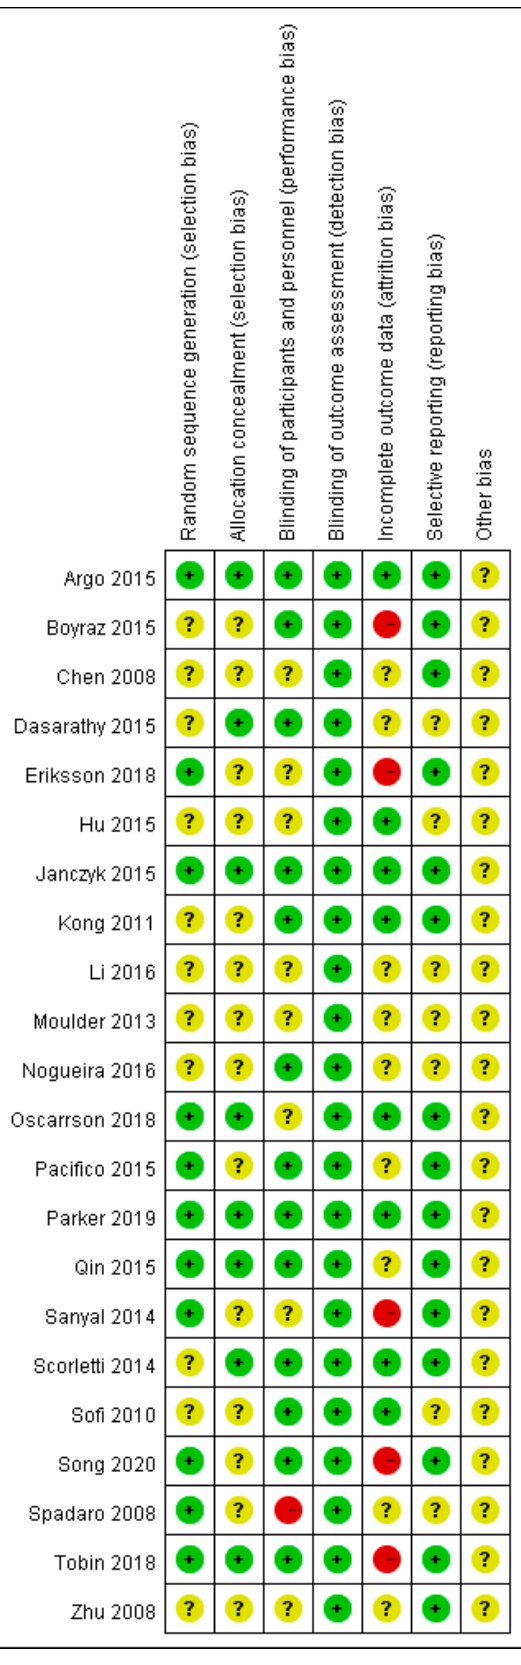
Figure 2. Risk of bias assessment of included trials. Green dots represent low risk of bias, with yellow and red for unclear and high risk of bias, respectively.